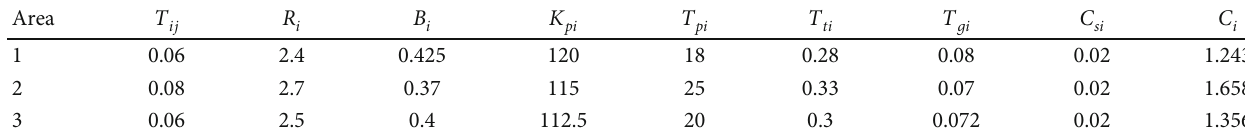
Table 1: Speci fi cation of three-area electrical